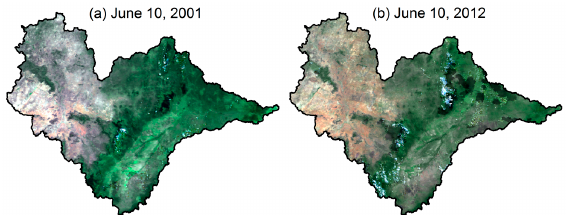
Figure 9. Satellite imageries for the years 2001 ( a ) and 2012 ( b ) mapped as red, green, and blue (RGB) (648, 555, and 470 nm). The deep and light green colours represent dense and sparse forests respectively, other colours represent scattered vegetation (not discernible at 500 m resolution).